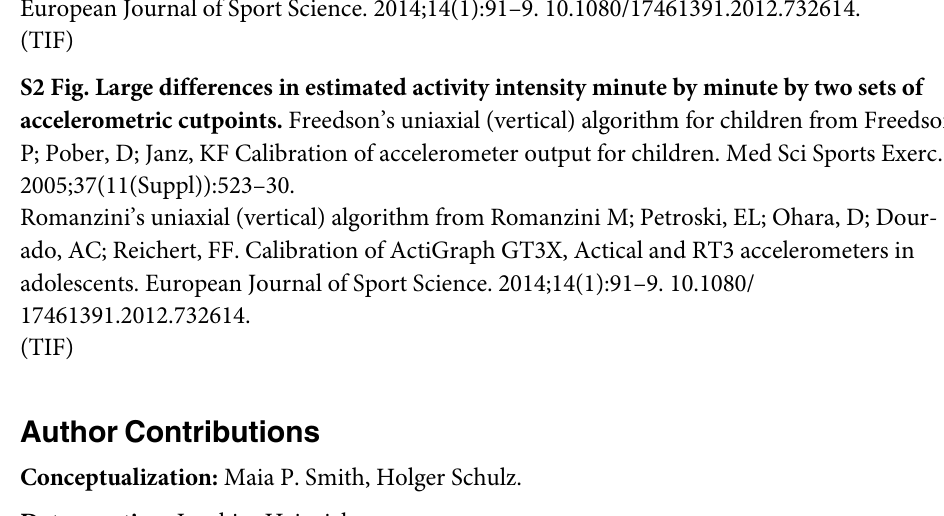
S2 Fig. Large differences in estimated activity intensity minute by minute by two sets of accelerometric cutpoints. Freedson’s uniaxial (vertical) algorithm for children from